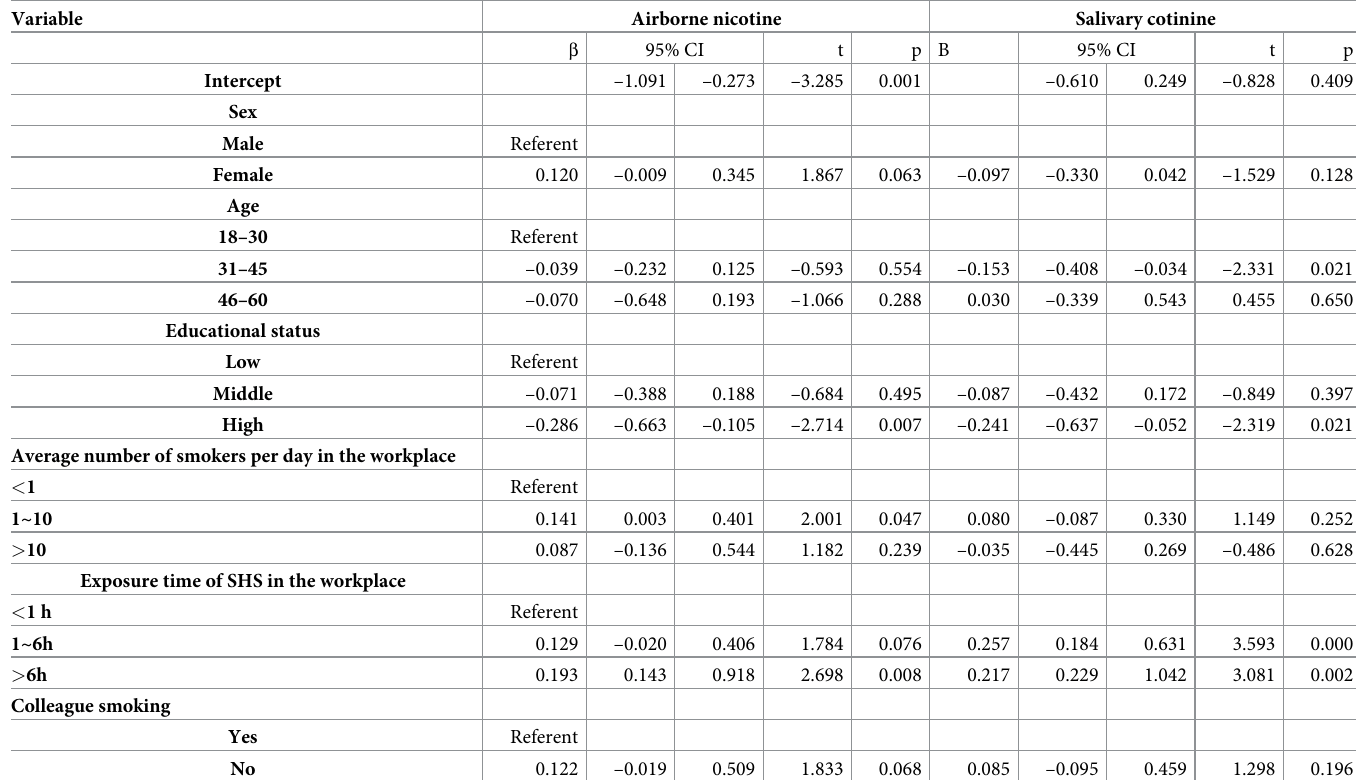
Table 2. Multivariate linear regression analysis of the employees’ demographics factors associated with airborne nicotine concentration and salivary cotinine con- centration (n = 222).